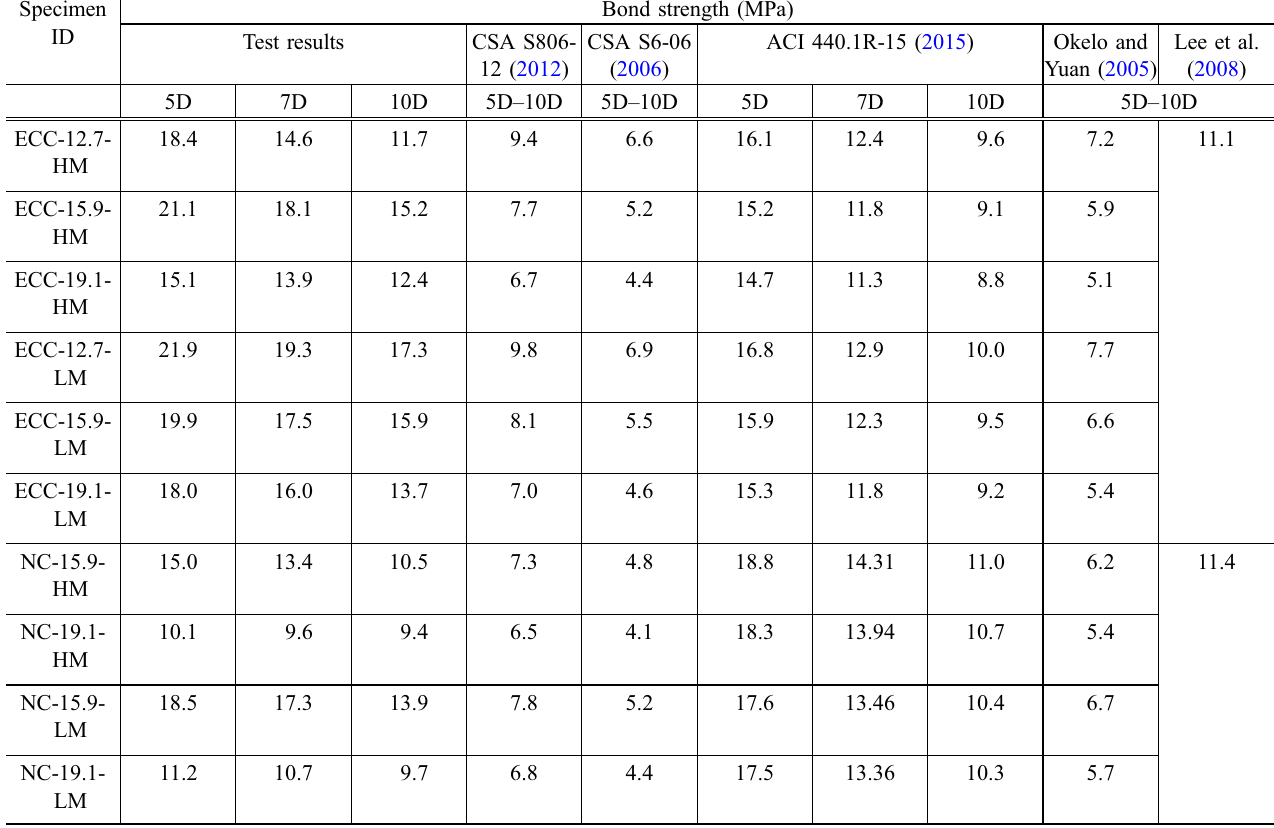
Table 6 Experimental and code predicted bond strengths for LM and HM bars. Specimen